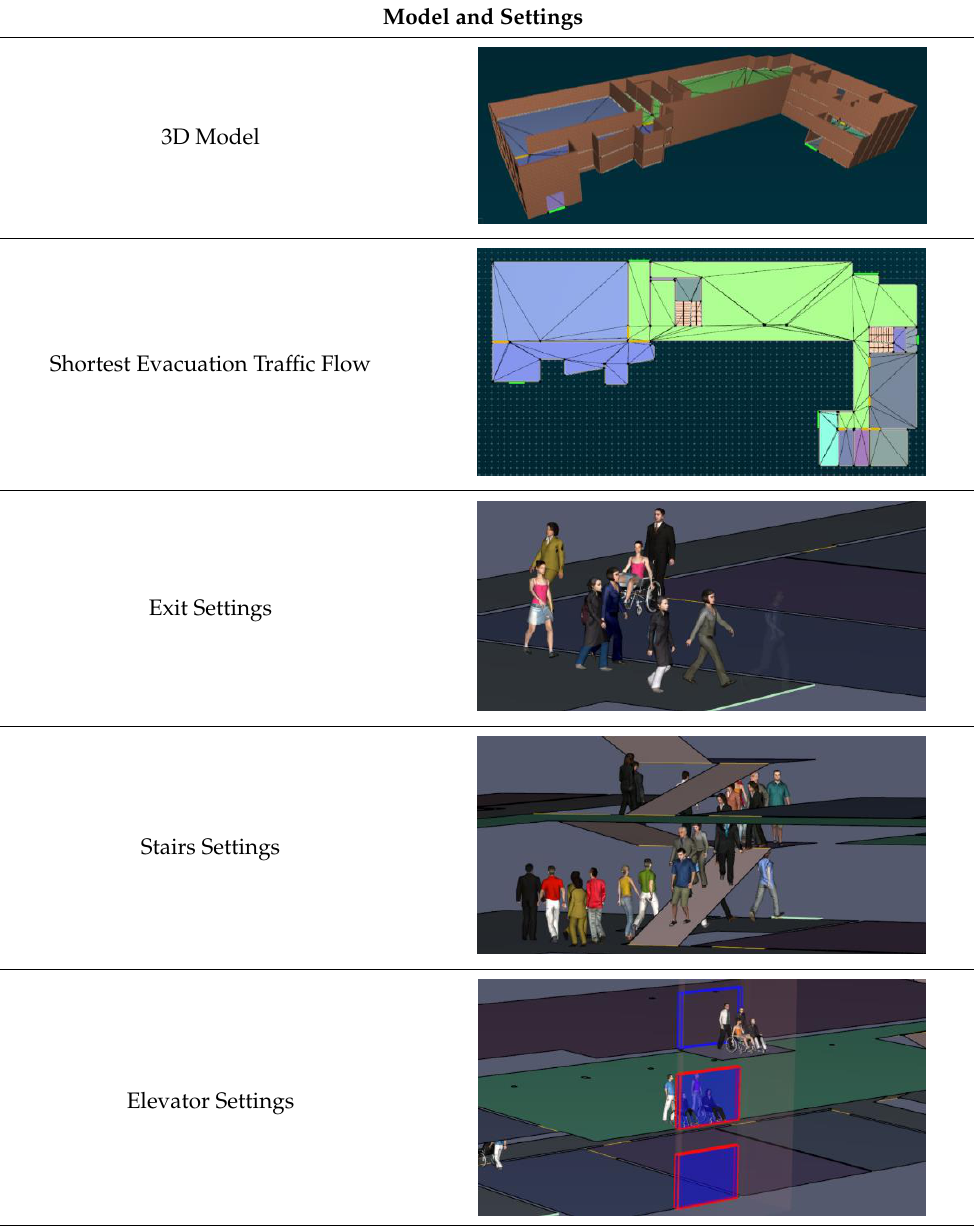
Table 2. Model setting.